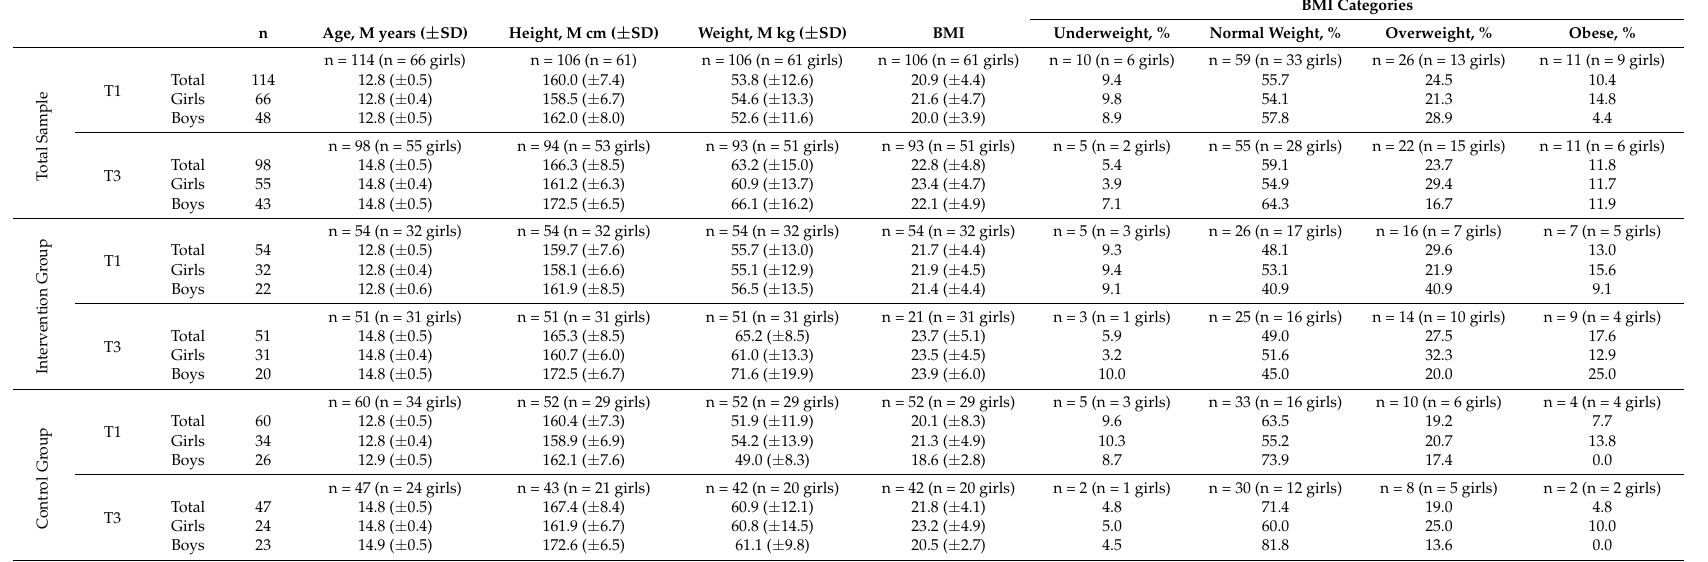
Table 2. Descriptive data for participants in the intervention group and the control group, during T1 (baseline, 2014) and T3 (endpoint, 2016),